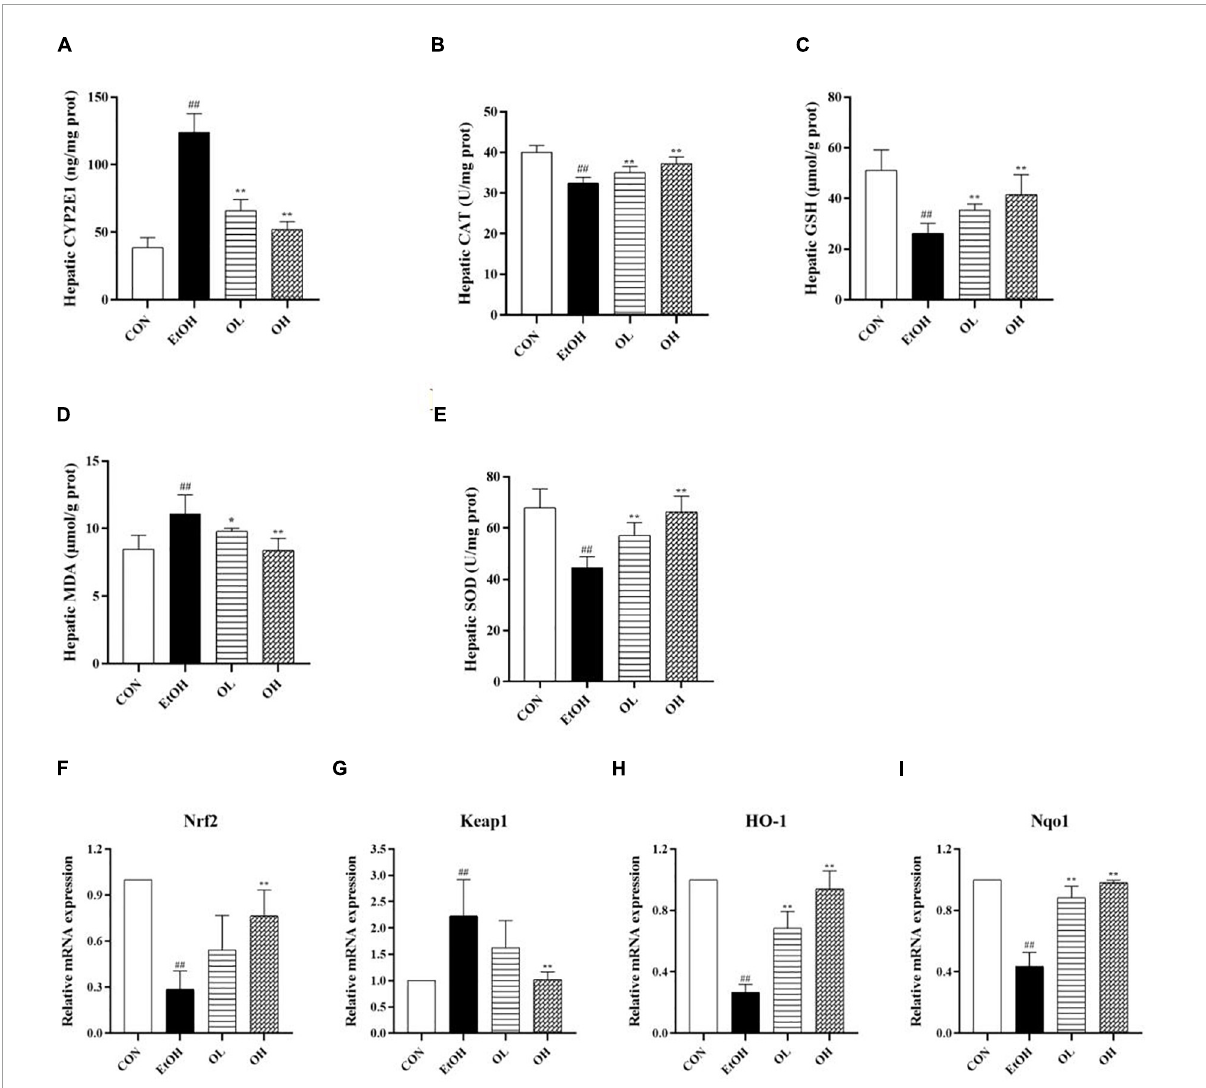
FIGURE4 Effect of OEB treatment on hepatic oxidative stress parameters and the expression levels of Keap1/Nrf2 signaling pathway-related genes of ALD mice: (A) hepatic CYP2E1 activity; (B) hepatic CAT activity; (C) hepatic GSH level; (D) hepatic MDA activity; (E) hepatic SOD activity; (F) Nrf2; (G) Keap1; (H) HO-1; and (I) Nqo1. CON, control group; EtOH, ethanol administration group; OL, low-dose OEB group; and OH, high-dose OEB group. Data are presented as “mean ± SD”. N = 8, for all groups. ## EtOH versus CON, P < 0.01; * OL or OH versus EtOH, P < 0.05; ** OL or OH versus EtOH, P <